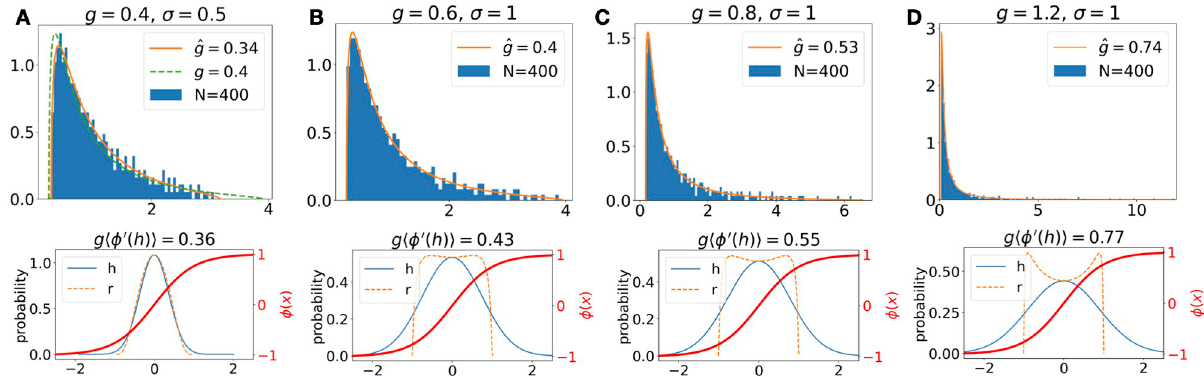
Fig 9. Covariance spectrum in nonlinear dynamics. A. Top: A histogram of covariance eigenvalues calculated from firing rate activities r i ( t ) of simulating a N = 400 network model according to Eq 33. The eigenvalues are normalized to have a mean equal to 1 for easy comparison of the shape (or equivalently the eigenvalues of the correlation matrix Section 3.8). Here g = 0.4 and σ = 0.5 (see Methods for additional numerical details). The green dashed line is the time-sampled theoretical spectrum (Section 3.7) using actual g and α , only shown in A for clarity of the plots. The length of the simulated data corresponds to α = N / T = 0.1. The orange curve is also the time-sampled theoretical spectrum except for using an effective ^ g that is fitted numerically to best match the simulated eigenvalues. Bottom: The blue curve is the histogram of h i ( t ) (aggregated across i and t ) and the orange dashed curve is the histogram of r ( t ). The overlaying red curve shows the nonlinearity ϕ ( x ) as a reference. The h�i in the title of each plot represents averaging i ϕ 0 ( h i ( t )) over all i and t . B-D . Same as A except for σ = 1 and g = 0.6, 0.8, 1.2, respectively. Only the fitted theoretical spectrum (orange curve) is shown for